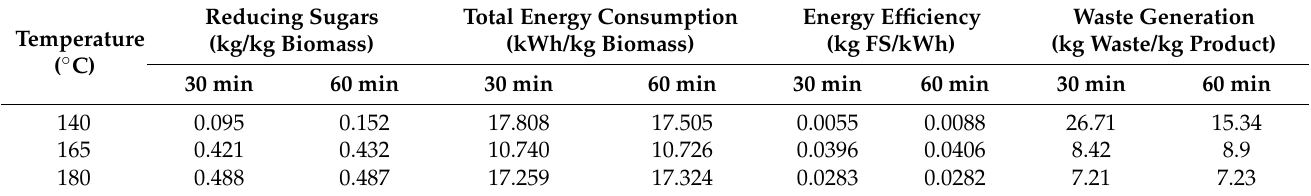
Table 2. The comparison of the energy efficiency and waste generation at different pretreatment